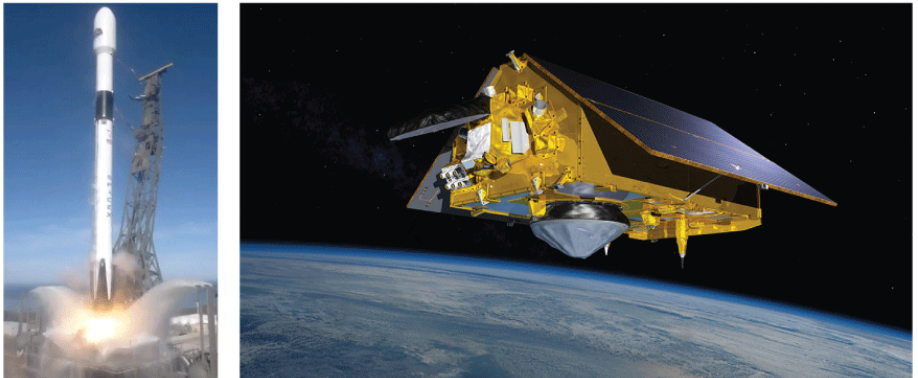
Figure 2. Sentinel-6 Michael Freilich was launched on 21 November 2020 and will be the first to offer fully focused SAR operation over all the ocean between 66 ◦ S and 66 ◦ N. To achieve a precise intercalibration it will be in a tandem orbit within 30 s of Jason-3 for 12 months. Images courtesy of NASA and